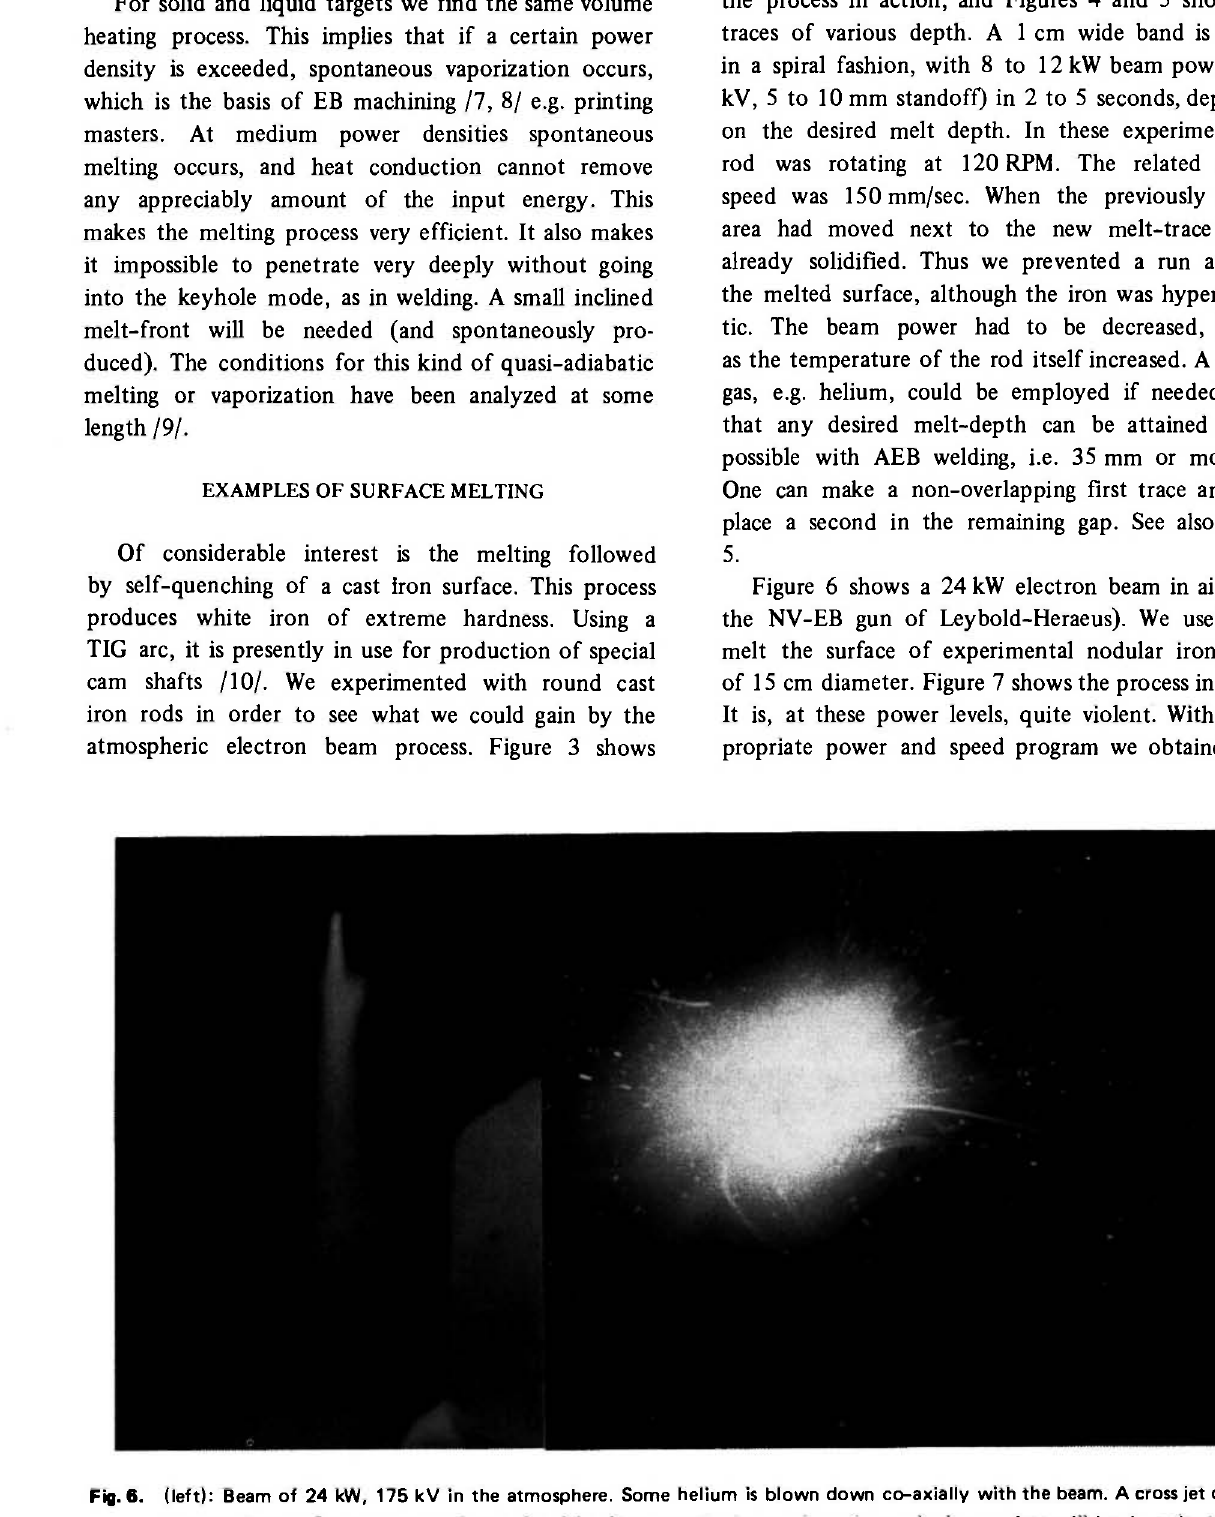
Fig. 6. (left): Beam of 24 kW, 175 kV in the atmosphere. Some helium is blown down co-axially with the beam. A cross jet of argon emerges from a 6 mm copper tube at the right. It crosses the beam where the work piece surface will be, in order to divert vapor, which may be generated, from the beam path. The argon flow is partly visible due to afterglow. The high power core of the beam is much slimmer than any such picture shows (see references /4, 5/). Fig. 7. (right): Surface melting in